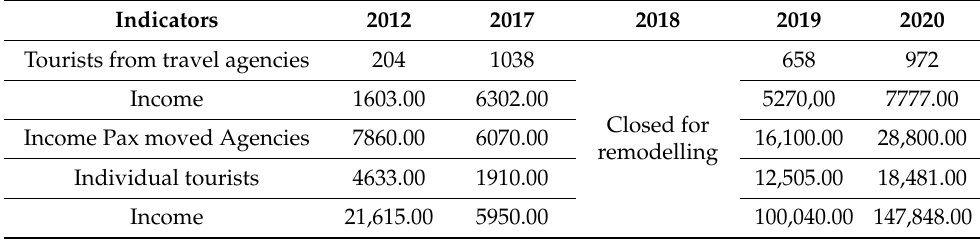
Table 1. Behavior of demand and economic income.